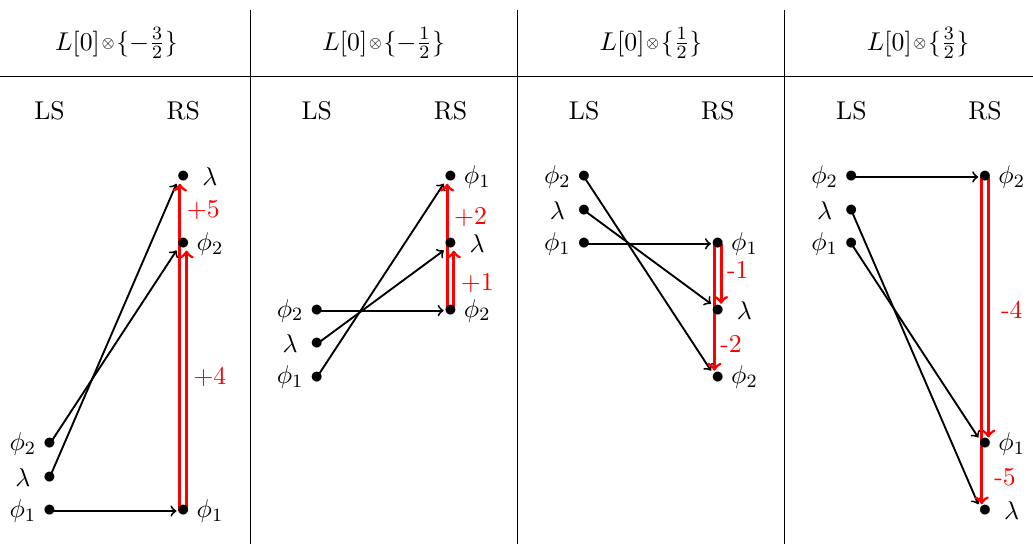
] , as we go from the 2 and φ is a scalar field. 2